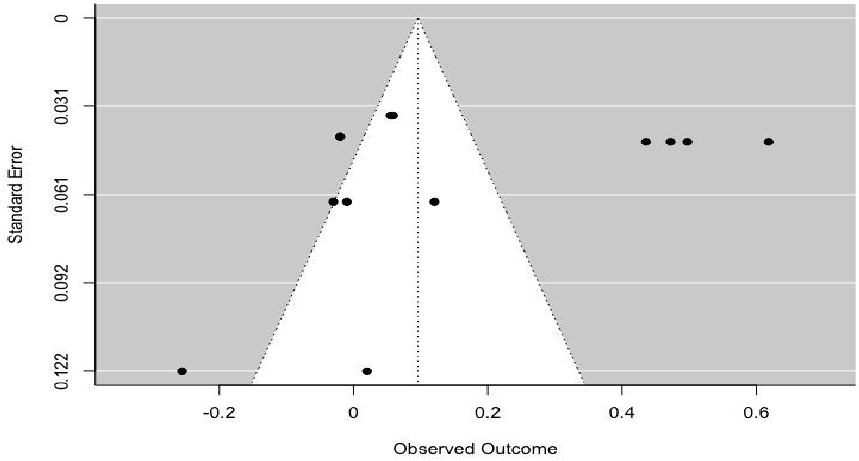
Figure 3. Funnel plot for the associations between punishment parental influence and PA level.